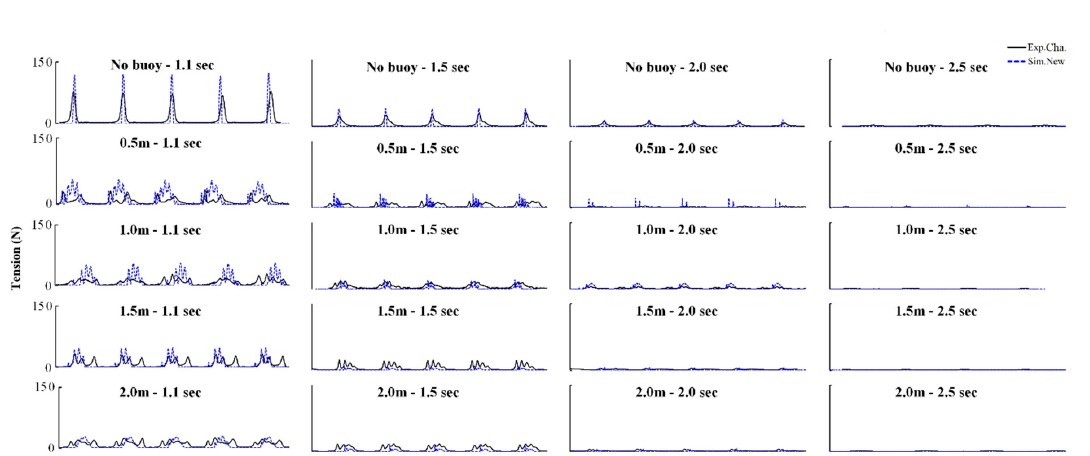
Figure 6. A time series of mooring tensions effected by the bridle-line length in a wave period of 1.1–2.5 s and a height of 0.15 m (Exp.Cha.: experiment by Cha and Lee [12], Sim.New: simulation of the current study).